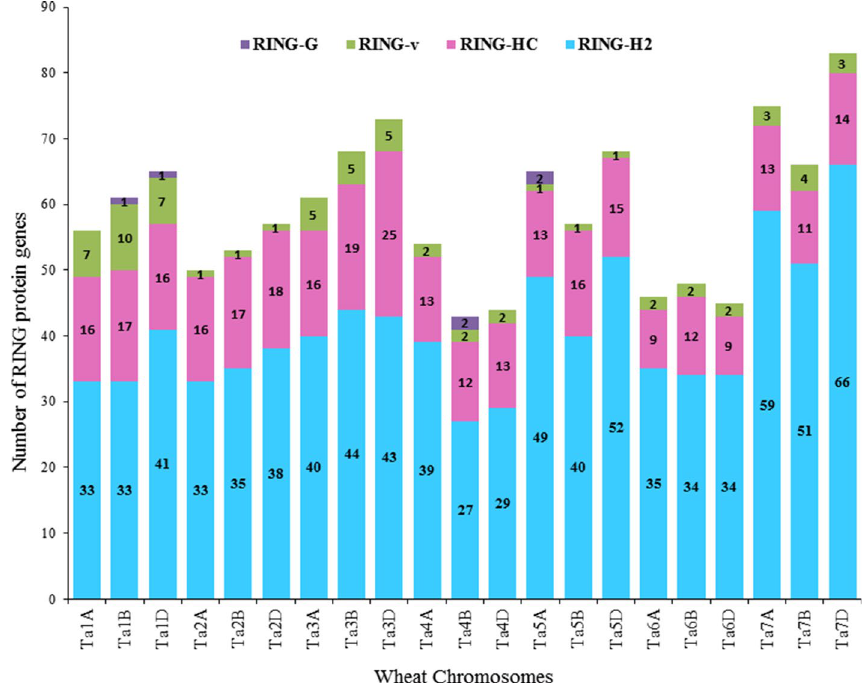
Figure 2. Histogram representing the distribution of RING protein genes in the identified four RING domain groups on 21 chromosomes (Ta1A to Ta7D) based on chromosomal locations from Ensembl Triticum aestivum database. Where, Ta stand for Triticum aestivum followed by chromosome